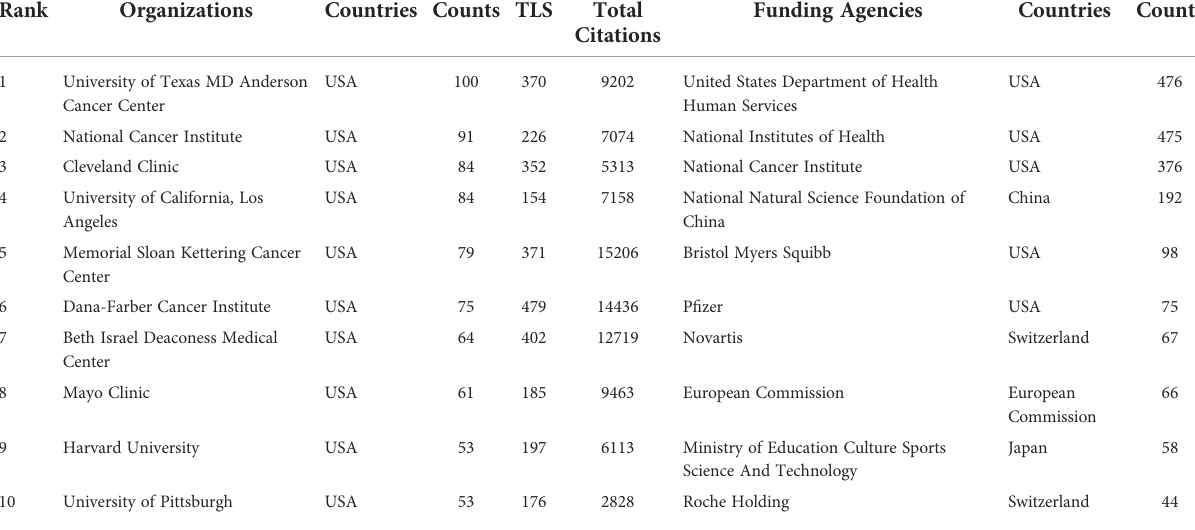
TABLE 2 The top 10 most productive organizations and funding agencies related to RCC immunotherapy research.